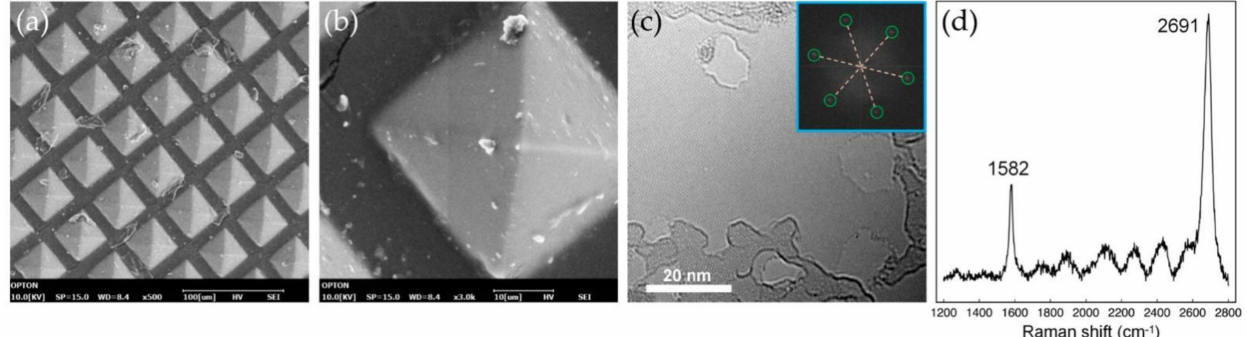
Figure 2. ( a ) Topological SEM image of inverted pyramid structures on graphene-enhanced PDMS; ( b ) Detailed SEM image on inverted pyramid structures with high magnification; ( c ) HRTEM image of the monolayer graphene, inset figure: FFT result of the graphene; and ( d ) Raman results with G and 2 D peaks of the graphene flakes in